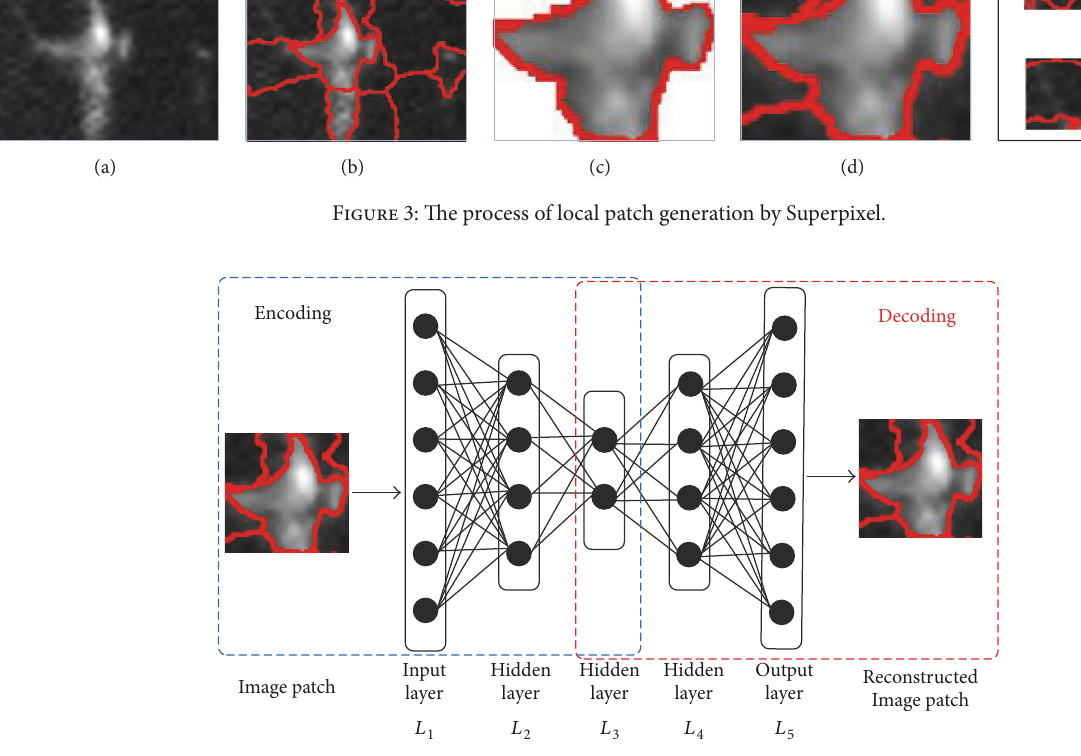
Figure 4: The process of stacked deep autoencoder